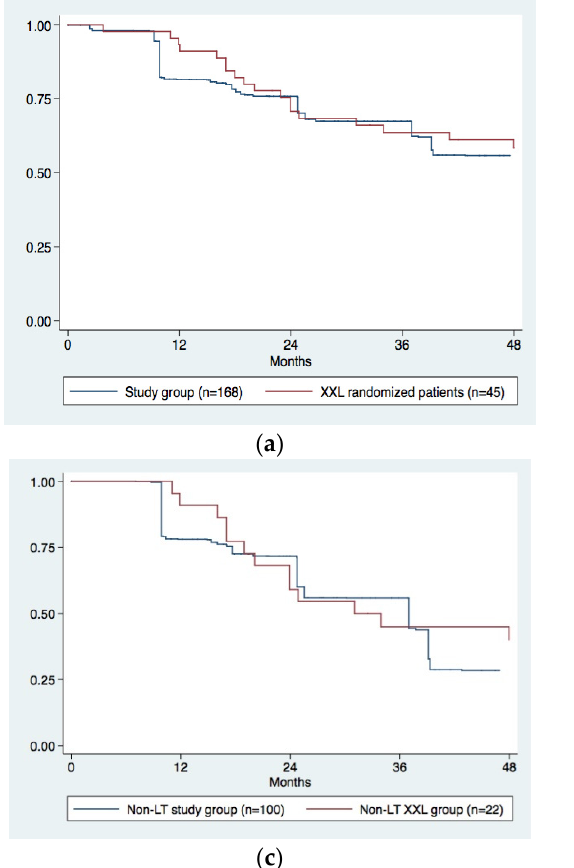
Figure 3. Kaplan–Meier survival curves comparing XXL and study groups: whole population ( a ); patients undergoing LT ( b ); patients in the non-LT XXL and study groups ( c ).